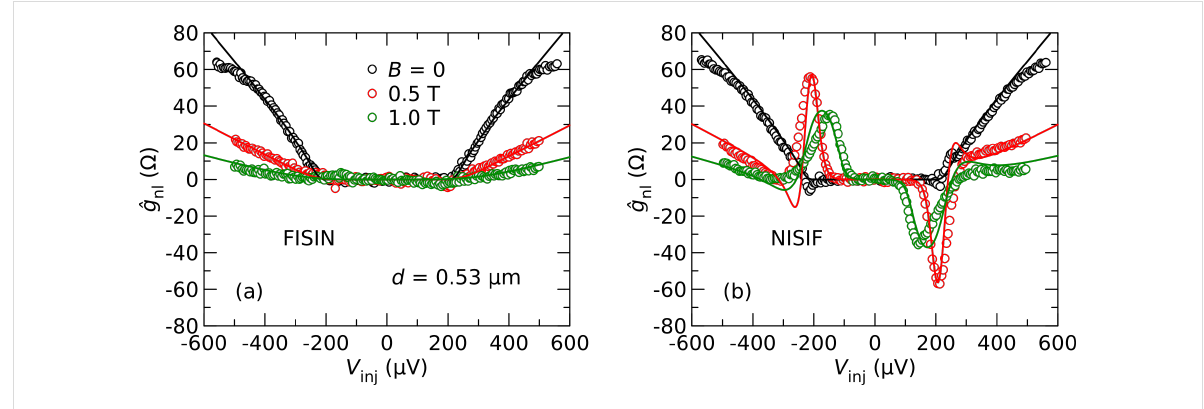
Figure 3: Normalized nonlocal conductance of one contact pair in an FISIN (a) and NISIF (b) configuration as a function of V inj for different magnetic fields B . Symbols are experimental data [18], lines are fits explained in the text.